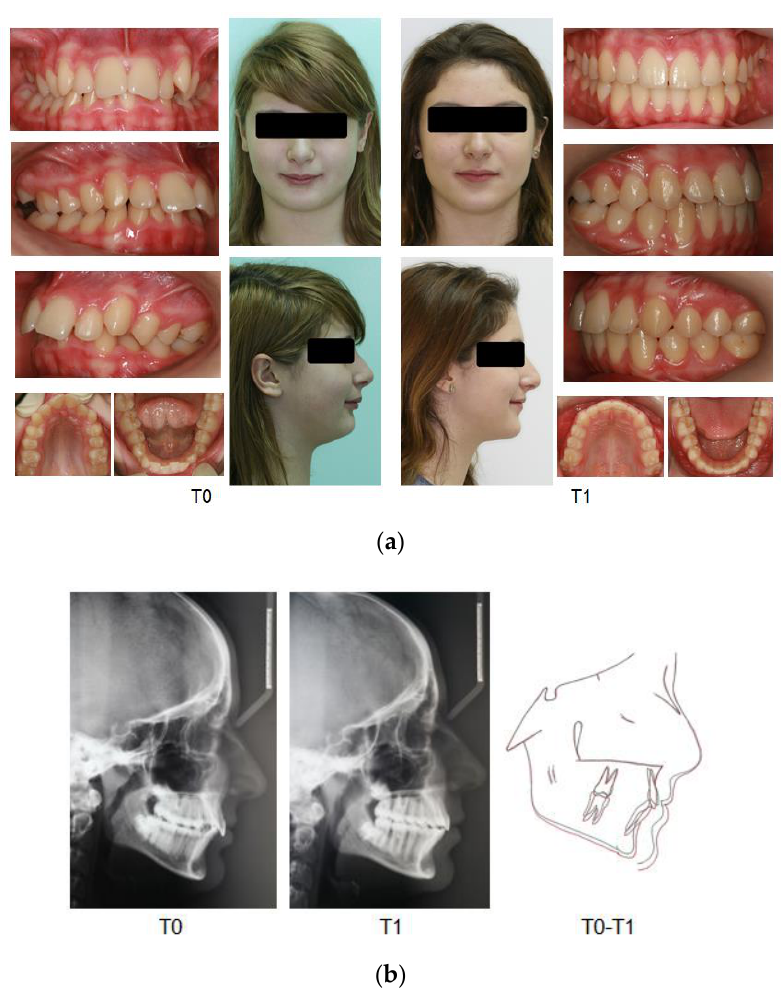
Figure 5. ( a ) Intraoral and extraoral photos before (T0) and after (T1) treatment with FSG (SWA). ( b ) Lateral cephalograms before (T0) and after (T1) treatment, and superimposition (T0-T1).